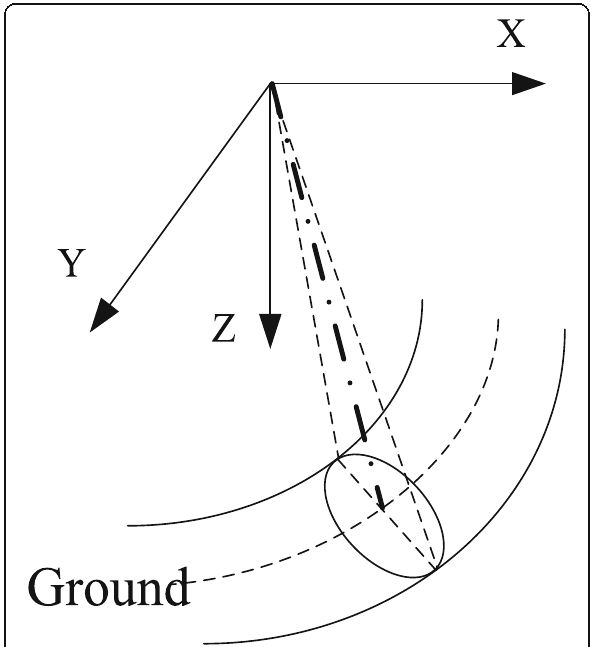
Fig. 2 Schematic diagram of a single ring cell